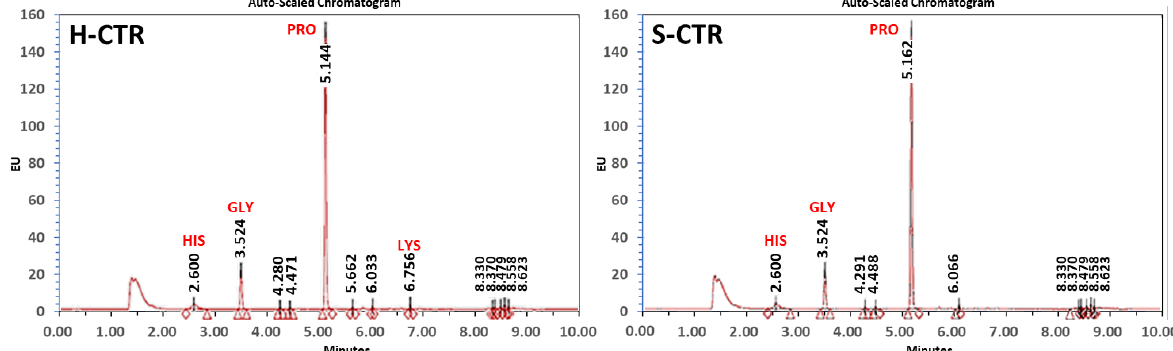
Figure 1. Ultra-performance liquid chromatography analysis of human native cartilage (H-CTR) and sturgeon native cartilage (S-CTR). The main peaks correspond to histidine (HIS), glycine (GLY), proline (PRO) and lysine (LYS). The numbers correspond to retention times (RT) obtained for each peak.